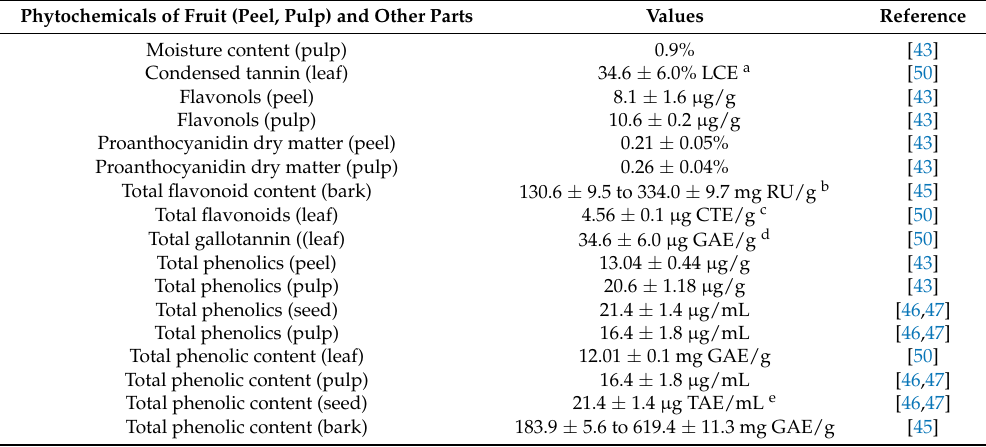
Table 4. Moisture content and phytochemical compound profiles isolated from Syzygium cordatum fruits and other plant